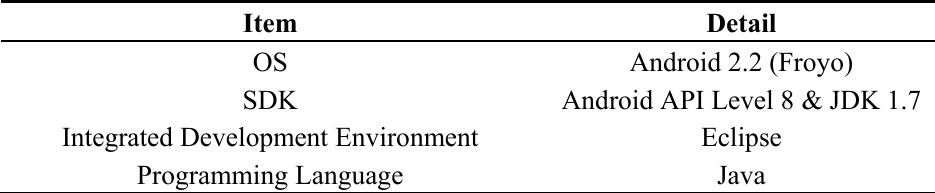
Table 2. Application development environment.